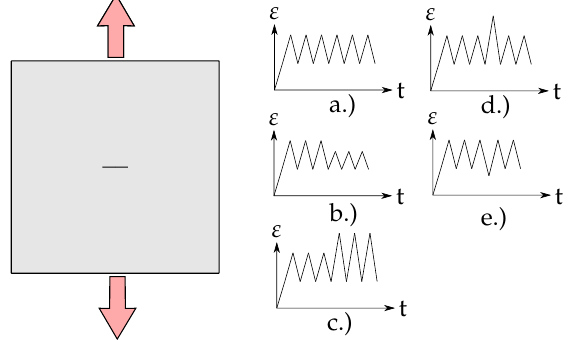
Figure 2. Direction of loading and investigated loading sequences.